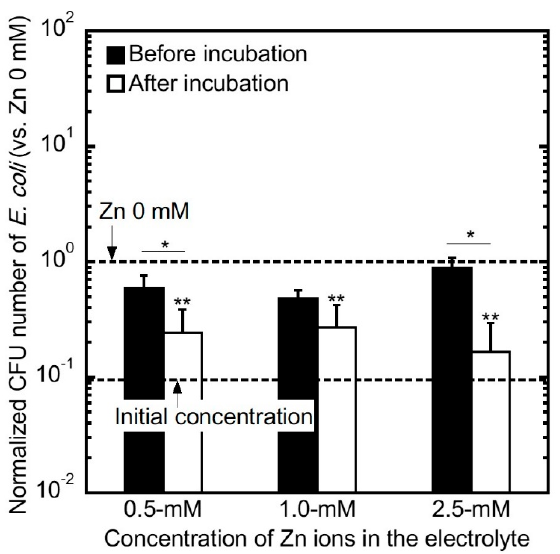
Figure 7. Antibacterial e ff ects of Ti MAO-treated in the electrolyte containing various concentrations of Zn. Data are shown as the mean ± SD. *: Significant di ff erence between specimens before and after incubation, **: Significant di ff erence against the specimen without Zn ( n ≥ 3, P <